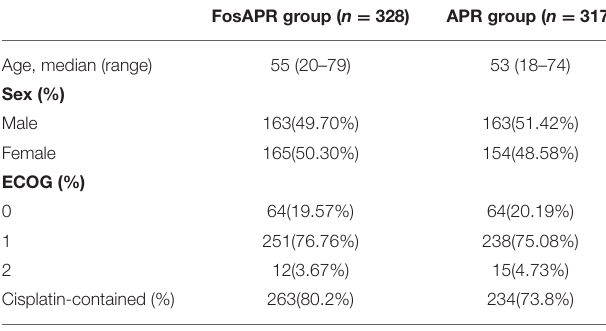
TABLE 1 | The baseline characteristics of patients in the study.